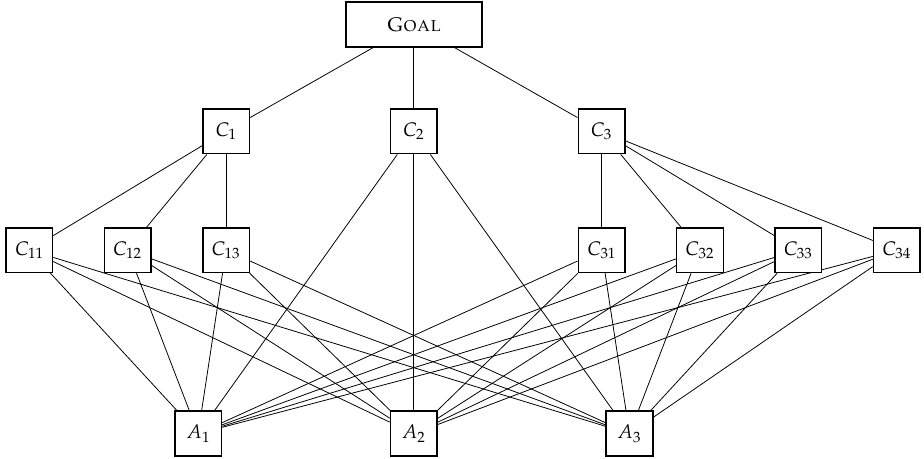
Figure 3. An example of a structure with three criteria ( C 1 to C 3 ), seven subcriteria ( C 11 to C 34 ), and three alternatives ( A 1 to A 3